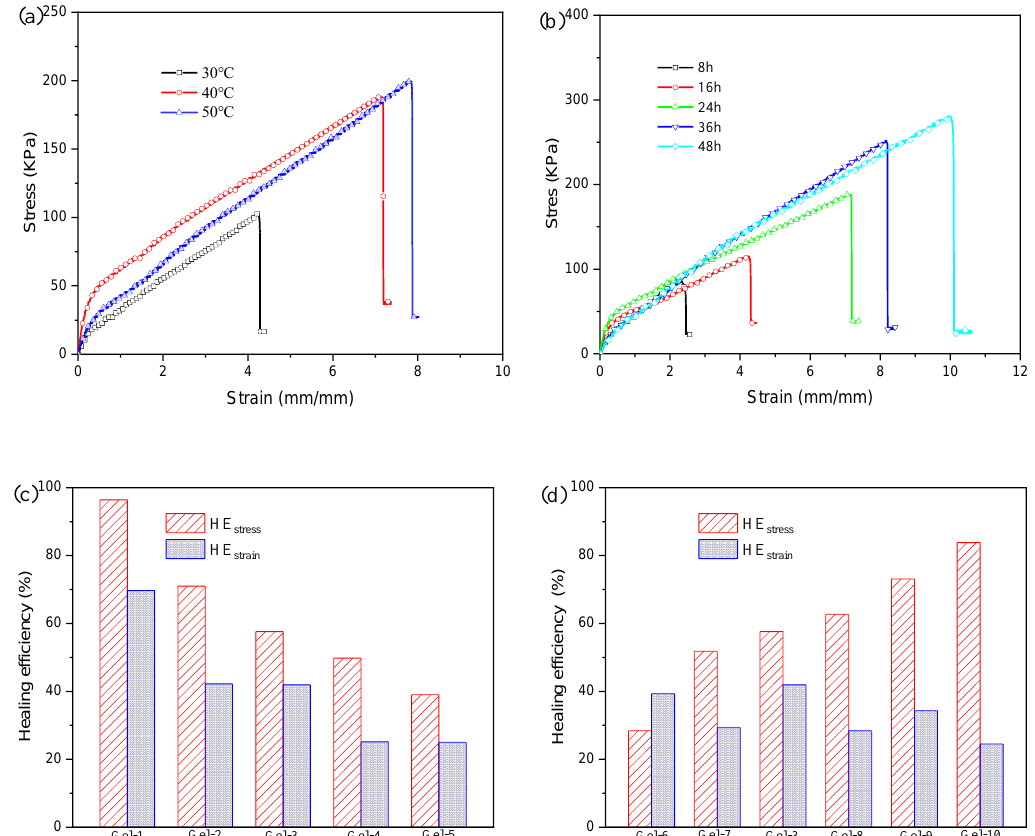
Figure 9. Tensile stress-strain curves ( a,b ) of healed sample Gel-3: ( a ) various self-healing temperatures; ( b ) various self-healing times; Healing e ffi ciency ( c,d ): ( c ) hydrogels with di ff erent Am / AAc ratios; ( d ) hydrogels with di ff erent Fe 3 + concentrations.